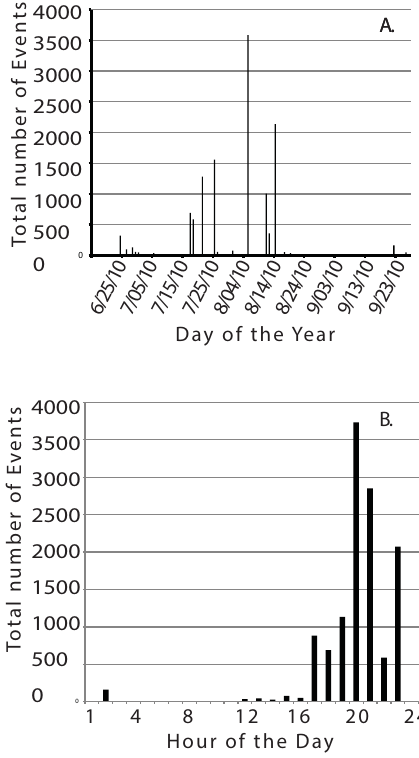
Fig. 3. Histogram of numbers of events for the time period of June– September 2010 as a function of (A) date and (B) hour of the day.